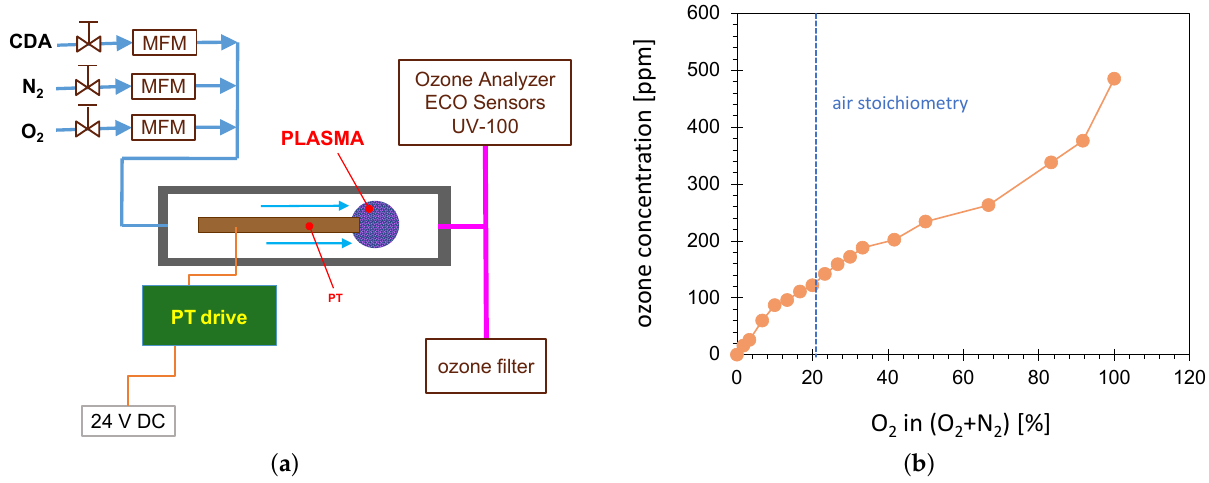
Figure 6. Measurement of the concentration of ozone generated by PCPG in the flow of pure gas mixtures. ( a ) setup; ( b ) ozone concentration as a function of oxygen percentage in an oxygen–nitrogen gas mixture, measured at a total gas flow of 6 SLM and PCPG power of 8.3